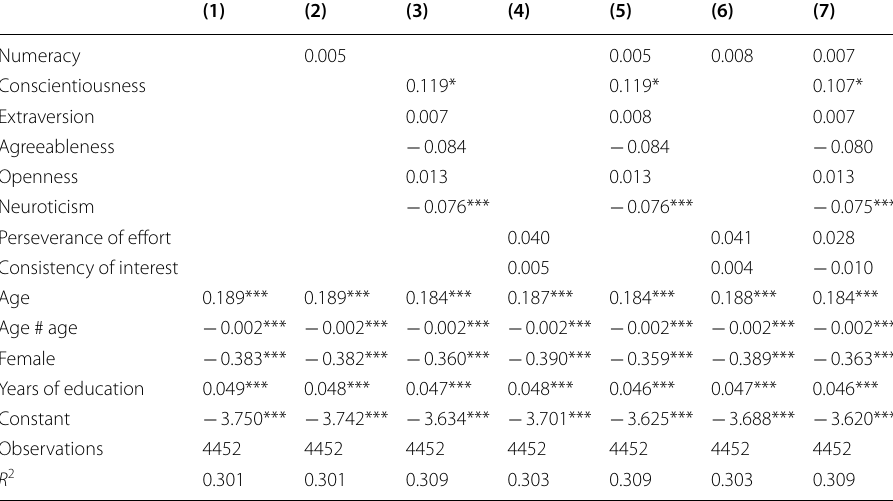
Table 11 Self-declared labour force participation and cognitive and non-cognitive skills